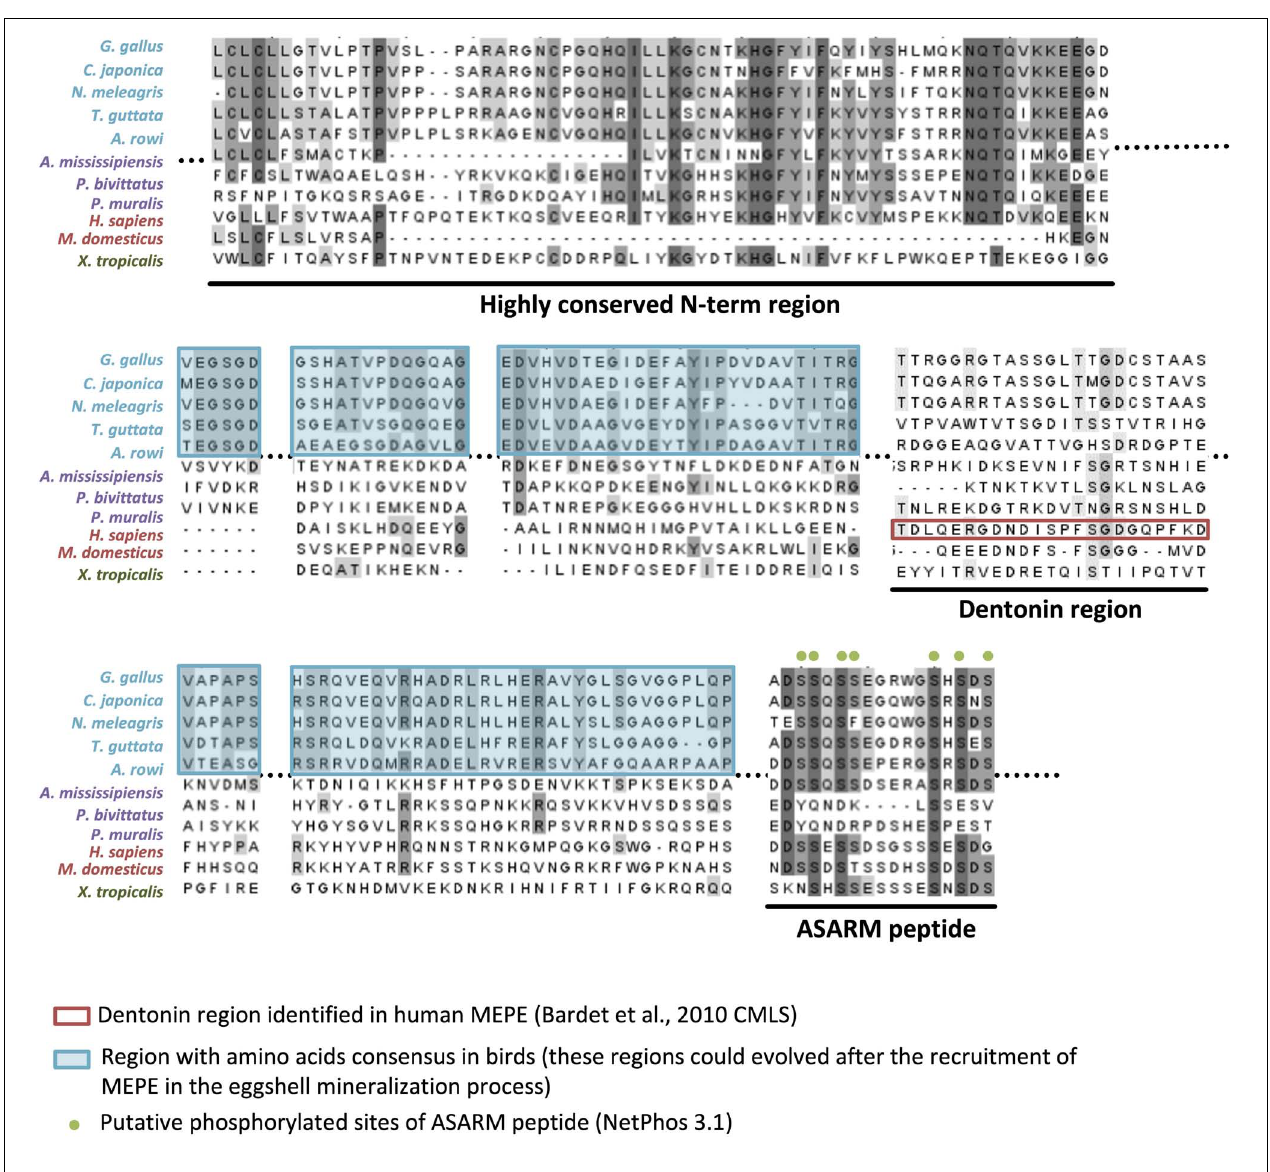
FIGURE 7 | Multiple alignment of OC-116/MEPE proteins in tetrapods. The alignment was built with ClustalW (www.phylogeny.fr) and edited with Jalview v2.11.1.4 (https://www.jalview.org/). Gray colors of letters correspond to percentage of identity (dark gray > 80% identity, medium gray > 60% identity, and light gray > 40% identity). The dentonin region identified in human MEPE, and regions with amino acid consensus in birds, are, respectively, framed in red and blue. Putative phosphorylated sites of the ASARM (acidic, serine, and aspartic acid-rich motif) peptide are indicated by green dots above the alignment. Sequences aligned are from Gallus gallus (AAF00982.3), Coturnix japonica (XP_015716951.1), Numida meleagris (XP_021251779.1), Taeniopygia guttata (XP_030127798.1), Apteryx rowi (XP_025920573.1), Alligator mississippiensis (XP_019343676.1), Python bivittatus (XP_025029286.1), Podarcis muralis (XP_028598766.1), Homo